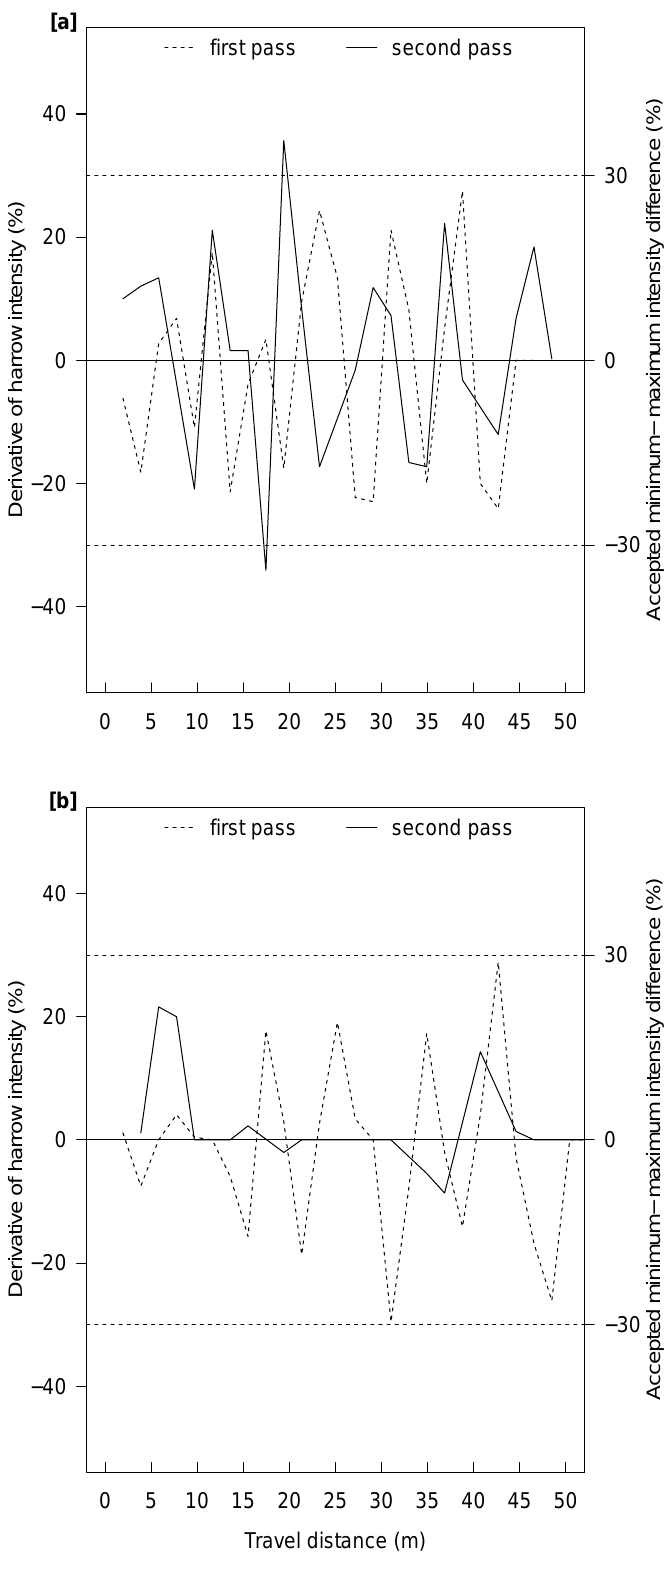
Figure 6. Harrow intensity adjustment needed per time (s) on the first and second pass of Plot A ( a ) and Plot B ( b ). A 30% threshold was accepted to properly adjust the tine angle at 12 km h − 1 driving